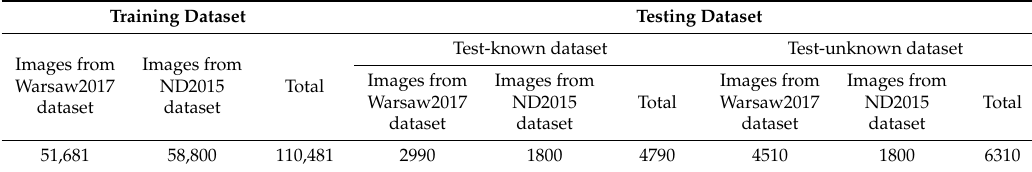
Table 8. Description of training and testing datasets of WARSAW-ND dataset.